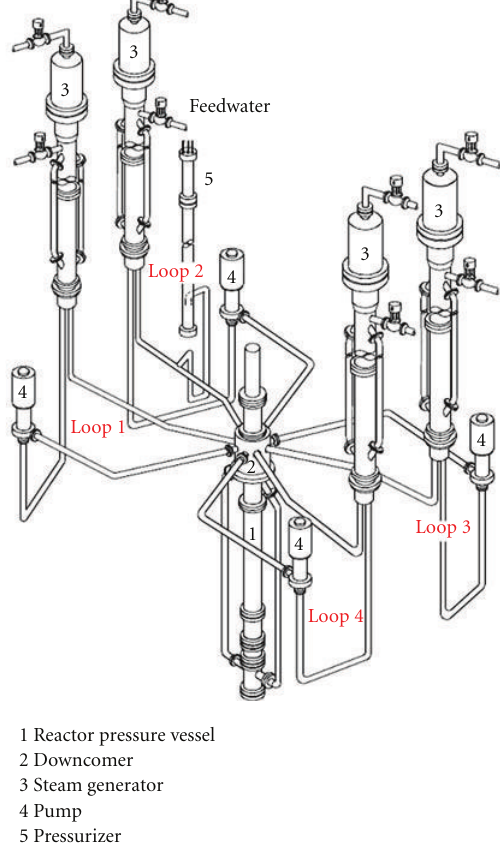
Figure 1: Layout of the PKL test facility [6].